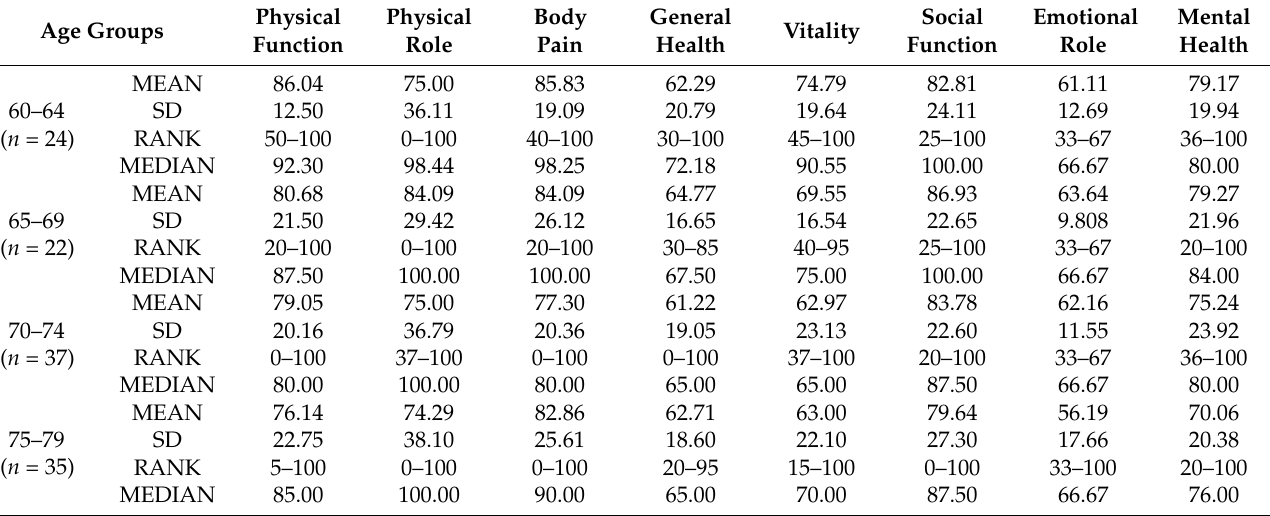
Table A2. Scores of the Health Scales of the SF-36 Questionnaire according to age